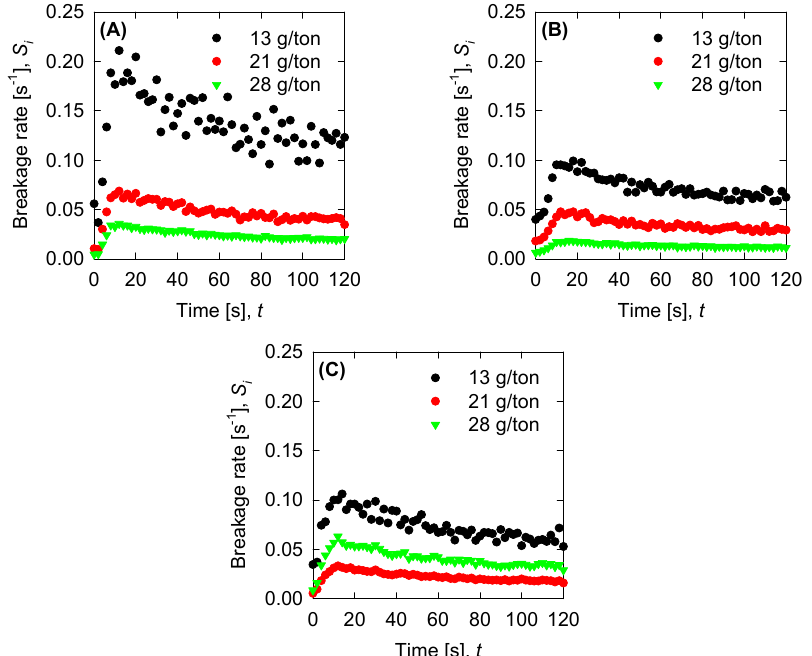
Figure 9. Breakage rate for the experimental data for ( A ) SW pH 8, ( B ) SW pH 11, and ( C ) T-SW pH